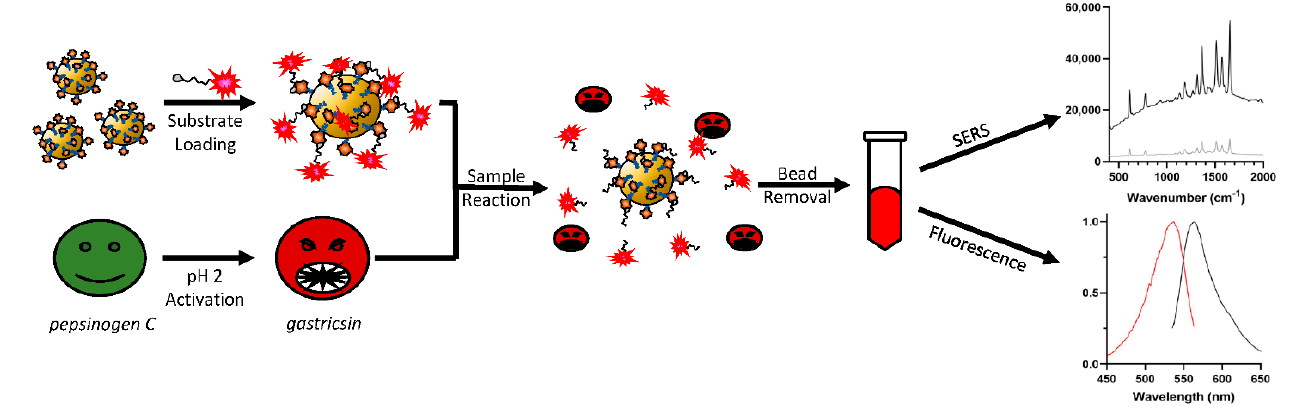
Figure 1. Scheme for conditional gastricsin activity assay. Briefly, magnetic beads are loaded with gastricsin substrate, and any unbound material is washed away. Gastricsin samples (research or clinical) are activated by incubation at pH 2 at room temperature prior to mixing with substrate-loaded beads. Equal volumes of enzyme solution and bead suspension are mixed for a predetermined amount of time, then the beads are removed with a magnetic tube rack. The resulting solution contains enzyme and reaction product at pH 2, which is quantified by either fluorescence or SERS measurements.